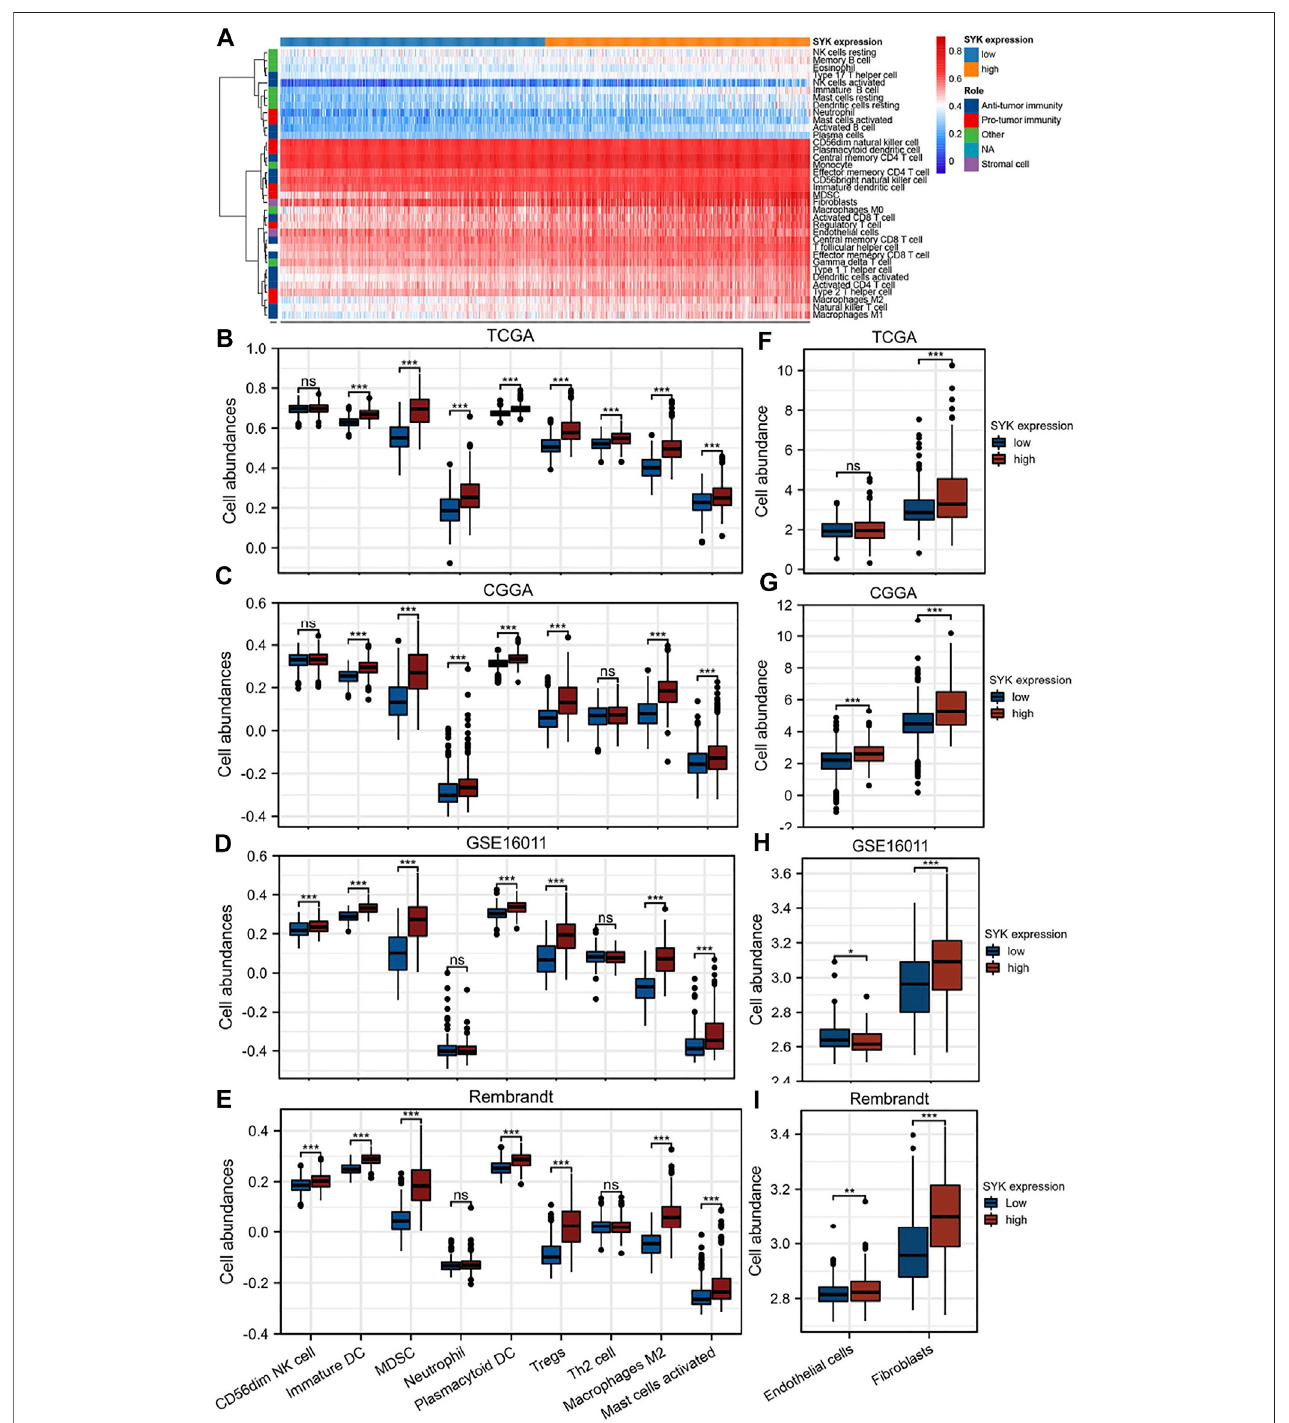
FIGURE 6 | Correlation of SYK expression with immune and stromal in fi ltration levels in diffuse gliomas. (A) Heatmap showing the landscape of immune cells and stromal cells in the TCGA cohort. (B – E) The association between the mRNA expression of SYK and the abundance of seven types of protumor immune cells in the four cohorts. (F – I) TheassociationbetweenSYKexpressionandtheabundanceofendothelialcellsand fi broblastsinthefourcohorts(-nosigni fi cance,* p < 0.05,** p < 0.01, and *** p < 0.001).